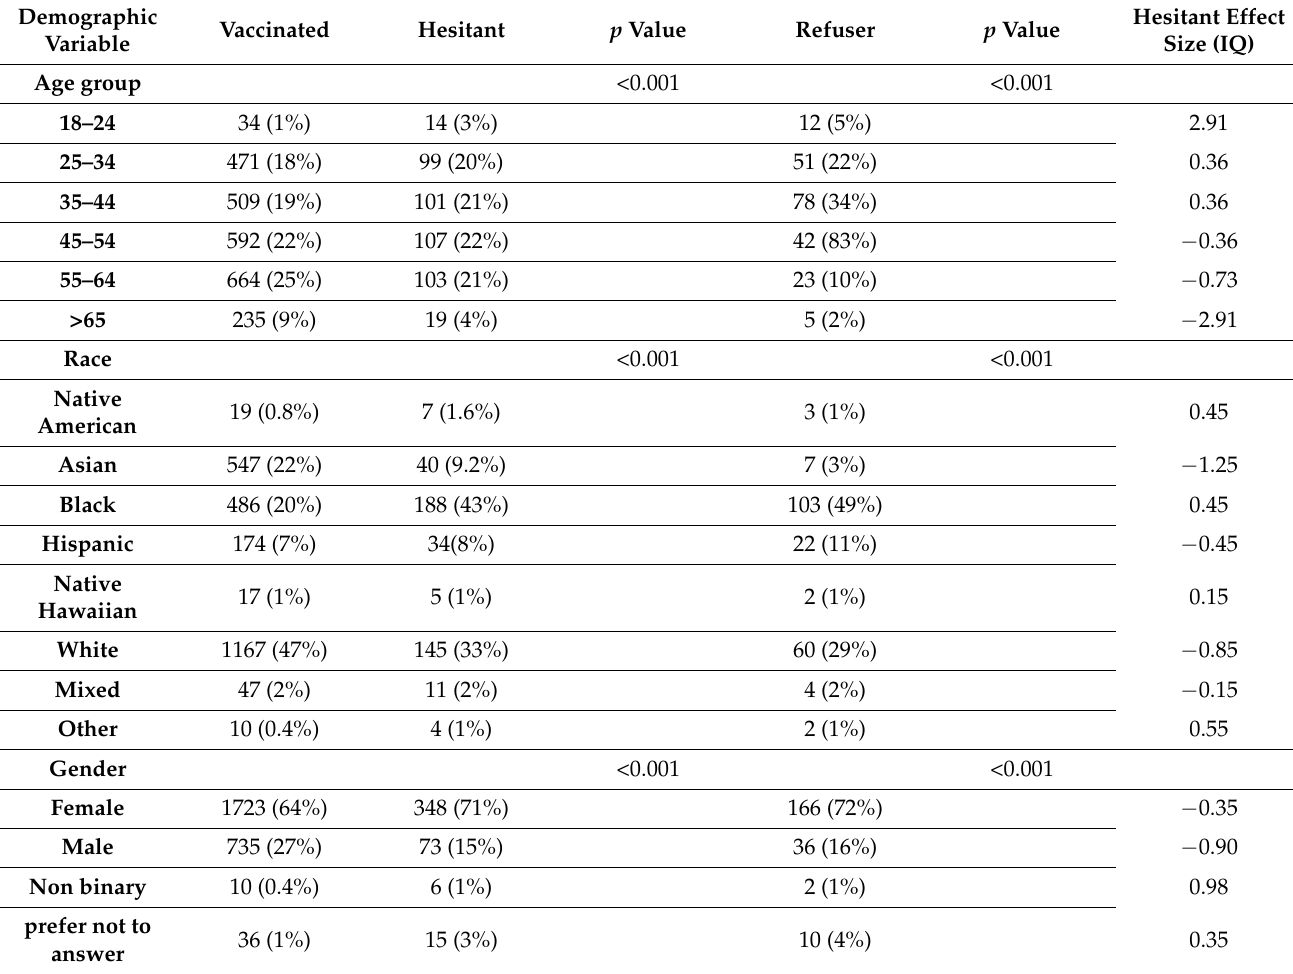
Table 3. Associations between demographics and COVID-19 vaccine